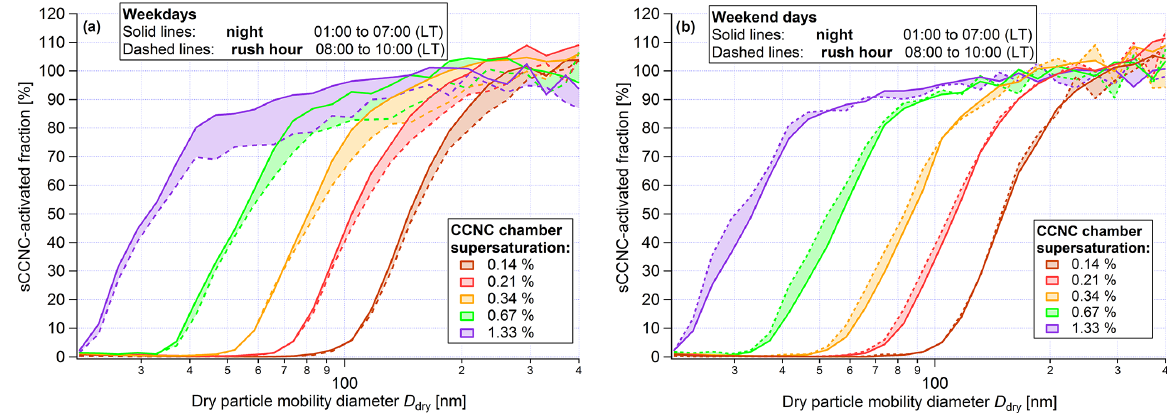
Figure 6. Averaged sCCNC-activated fraction spectra (from sCCNC measurements). The data set of the whole campaign is temporarily split by (a) weekdays versus (b) weekend days, and also by night-time versus morning rush